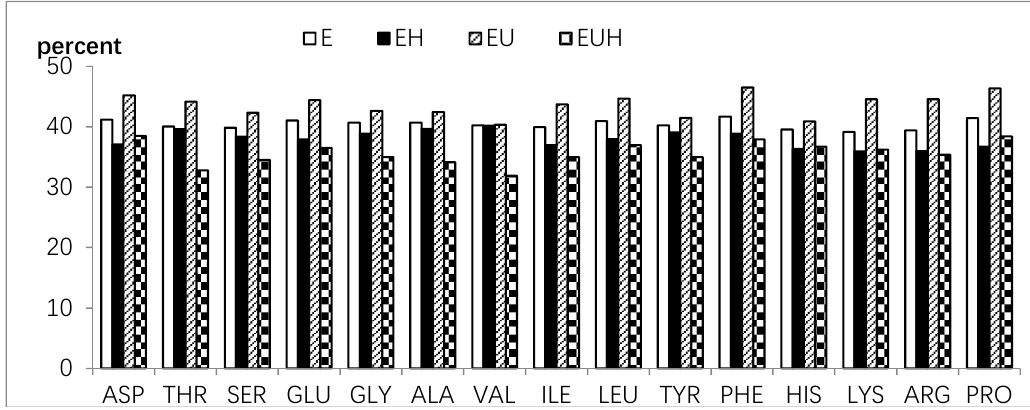
Figure 5. The single amino acid absorption ratio of oat protein hydrolysates in different groups.